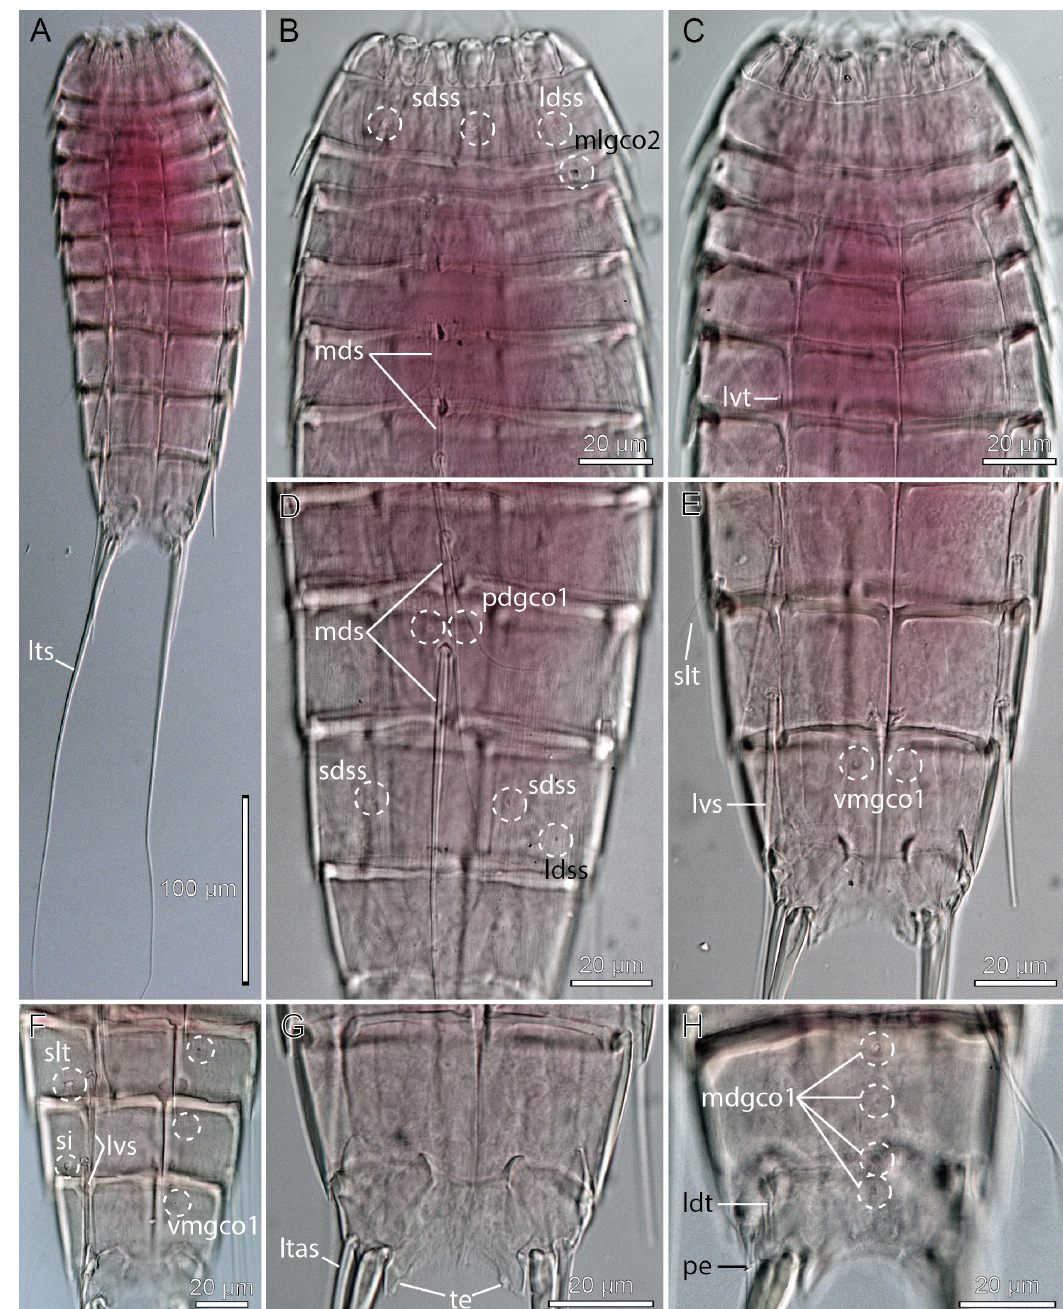
Fig. 5. Light micrographs showing overviews and details of Echinoderes dubiosus sp. nov., holotype, ♀ (A–E, G) (NHMD-213583) and paratype, ♂ (F, H) (NHMD-213592). A . Ventral overview. B . Segments 1 to 6, dorsal view. C . Segments 1 to 6, ventral view. D . Segments 7 to 10, dorsal view. E . Segments 8 to 11, ventral view. F . Segments 8 to 11, ventral view. G . Segments 10 to 11 in female, ventral view. H . Segments 10 to 11 in male, dorsal view. Abbreviations: ldss = laterodorsal sensory spot; ldt = laterodorsal tube; ltas = lateral terminal accessory spine; lts = lateral terminal spine; lvs = lateroventral spine; lvt = lateroventral tube; mdgco1 = middorsal glandular cell outlet type 1; mds = middorsal spine; mlgco2 = midlateral glandular cell outlet type 2; pdgco1 = paradorsal glandular cell outlet type 1; pe = penile spines; sdss = subdorsal sensory spot; si = sieve plate; slt = sublateral tube; te = tergal extensions; vmgco1 = ventromedial glandular cell outlet type